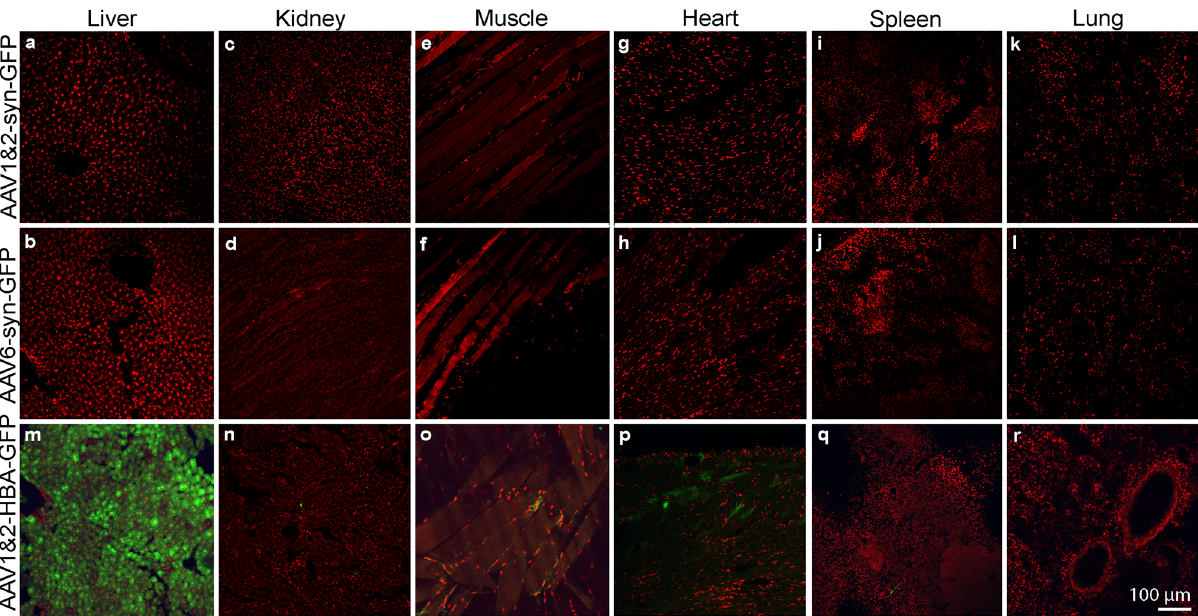
Figure 2. No detection of transgene expression in peripheral organs under syn promoter control. Intravenous administration of AAV1&2-syn-GFP and AAV6-syn-GFP resulted in no transgene expression in the liver ( a , b ), kidney ( c , d ), muscle ( e , f ), heart ( g , h ), spleen ( I , j ), and lung ( k , l ). Gene expression (GFP, green) after delivery of AAV1&2 under control of the human beta actin (HBA) promoter was conversely detected in the liver ( m ), kidney ( n ), muscle ( o ), heart ( p ), and spleen ( q ). No GFP expression was detected in the lung after injection of either AAV1&2-syn-GFP, AAV6-syn-GFP, or AAV1&2-HBA-GFP. Nuclear staining is shown with DAPI